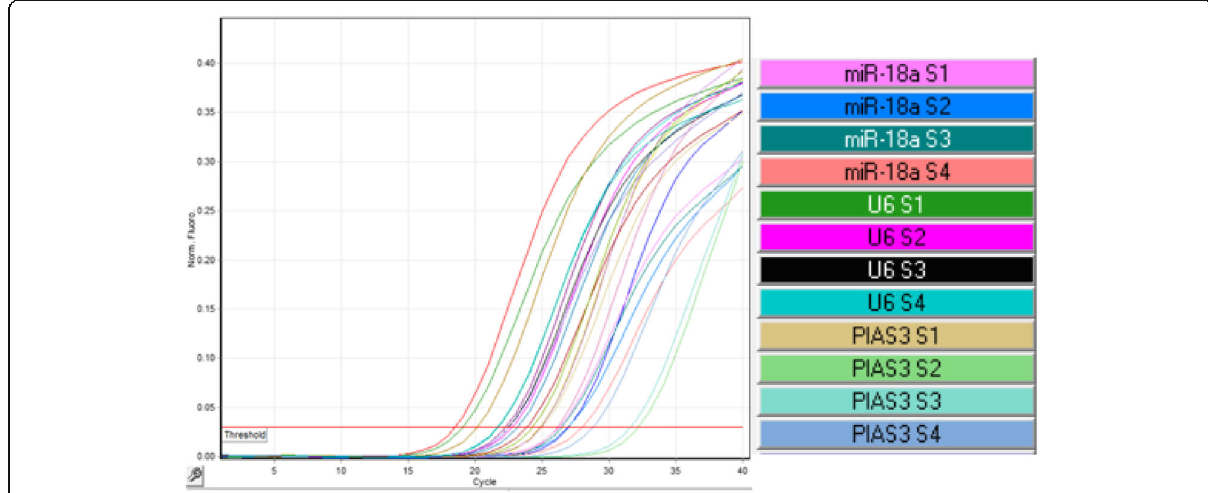
Fig. 2 Amplification plot produced in real-time PCR. S1, S2, S3, S4 for samples no. 1, 2, 3, and